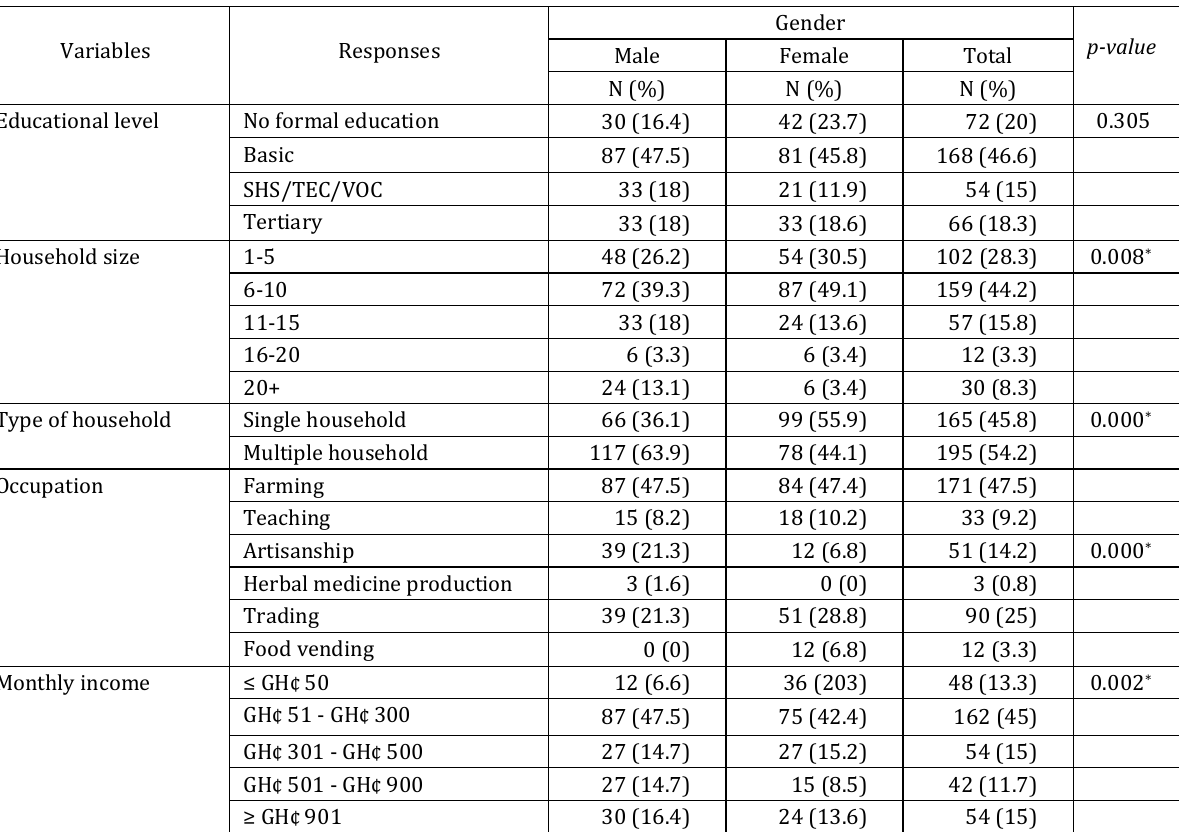
Table 2. Biodata of